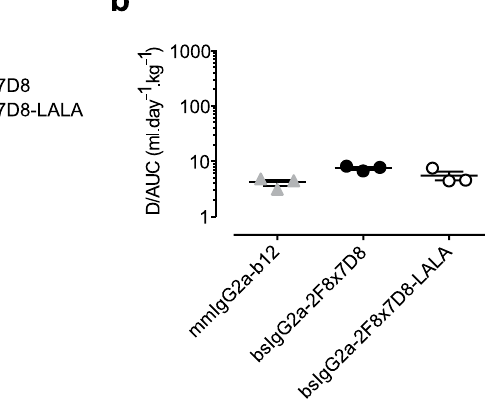
Figure 5. Total antibody plasma concentration over time ( a ) and plasma clearance rate ( b ) in C57Bl/6 J mice of mmIgG2a-derived bispecific antibodies. Mice (3 per group) were injected with the indicated antibodies (100 µ g/ mice). Blood samples were drawn at different times and plasma concentrations were determined by antigen- specific ELISA. Data represent mean ± SEM.